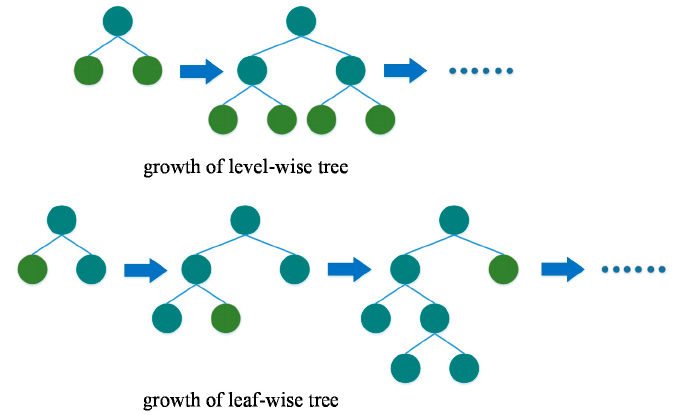
Figure 6. Process of decision tree learning using the growth of level-wise and leaf-wise.